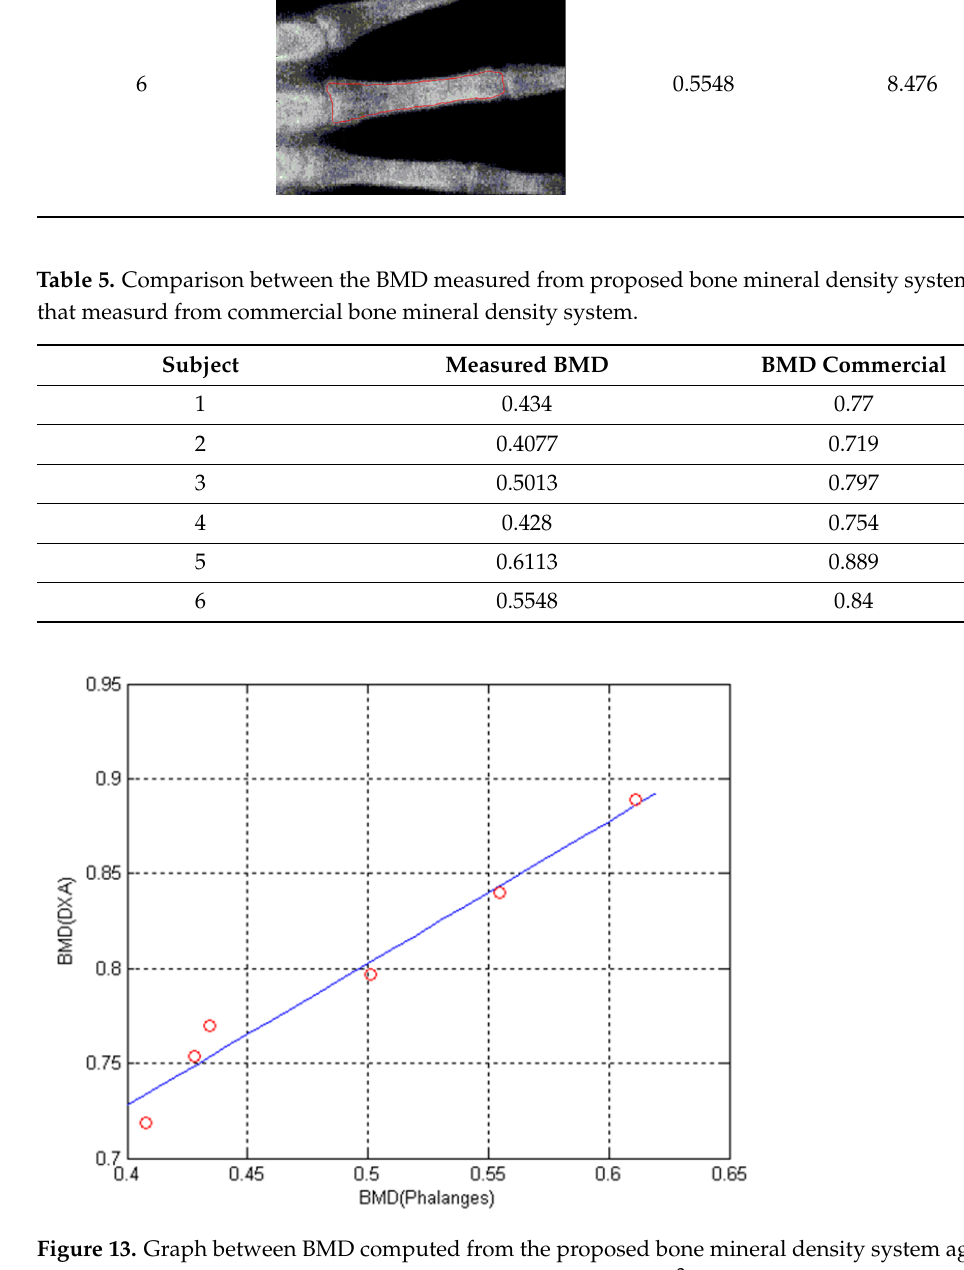
Figure 14. Plot of BMD computed from the proposed bone mineral density system (+) with meas- ured by commercial bone mineral density system (o) after normalization. 3.4. Design for Bone-Mineral Density Measurement To provide mobility of our system, we have designed a portable bone-mineral den- sity measurement system based on dual energy x-ray proposed by this manuscript as shown in Figure 15. Installed in the lead-protection case (i), the main components of the system are x-ray source (a) and x-detector (j, g). The x-ray source is a handheld dental x- ray device which is mounted on the top of the case. Our indirect x-ray detector consists of intensifying screen and CMOS Sensor. Intensifying screen converts x-ray to visible light. An image of illuminated intensifying screen is then captured with digital for further pro- cessing. To control energy level of x-ray, a 1-mm aluminum filter is used. The aluminum filter (c) is controlled by servo motor (b). When lower-energy x-ray is needed, servo motor will move the aluminum filter into the collimator (j) to attenuate the energy of x-ray. Rasp- berry Pi microcontroller is used to control the operation of the system including image acquisition and image processing.